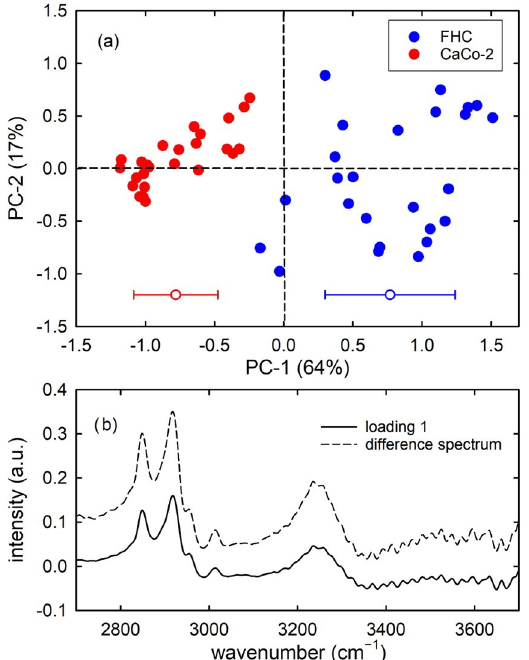
Figure 2. PC2 vs. PC1 score plot ( a ) for the healthy FHC cells (blue dots) and cancerous CaCo-2 cells (red dots) FTIR spectra. The mean and standard deviation of the PC1 score values are shown on the bottom side of ( a ). Results of the t-test point out that the two distributions of score values are significantly different ( p < 0.001). Difference of mean spectrum values (healthy-cancer signal) and loading 1 spectrum are reported in ( b ).